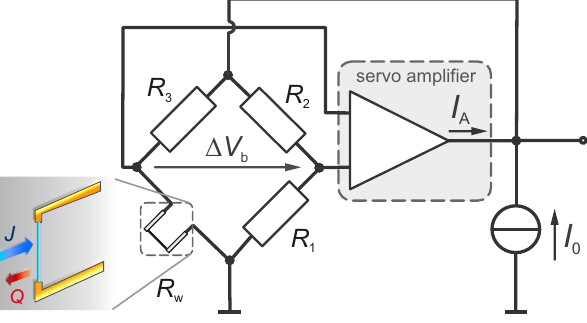
Figure 4. Basic principle of a hot wire anemometer in constant temperature mode